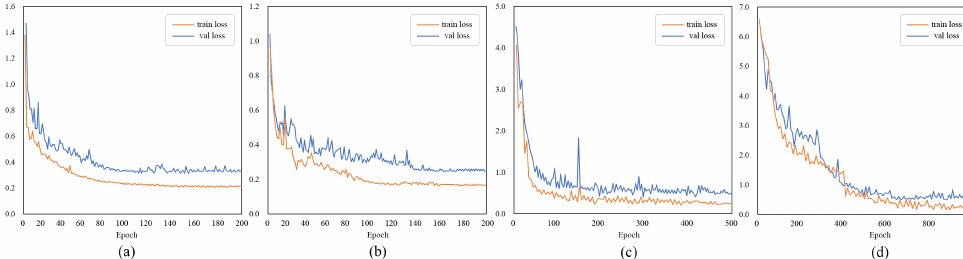
Figure 4. Loss curves during the training of XANet on different datasets. ( a ) Vaihingen dataset;